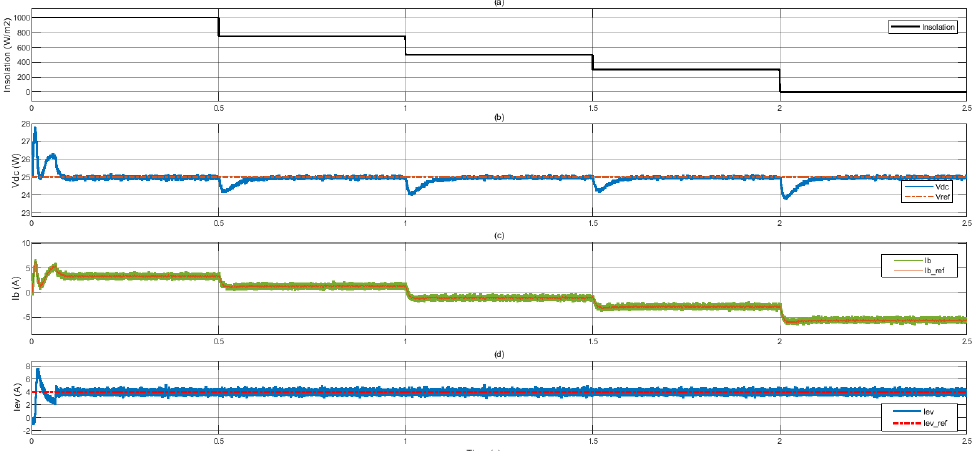
Figure 8. The system response with the PI controller: ( a ) the sun insolation level, ( b ) the DC bus voltage, ( c ) the ESS battery current, and ( d ) the EV battery current.